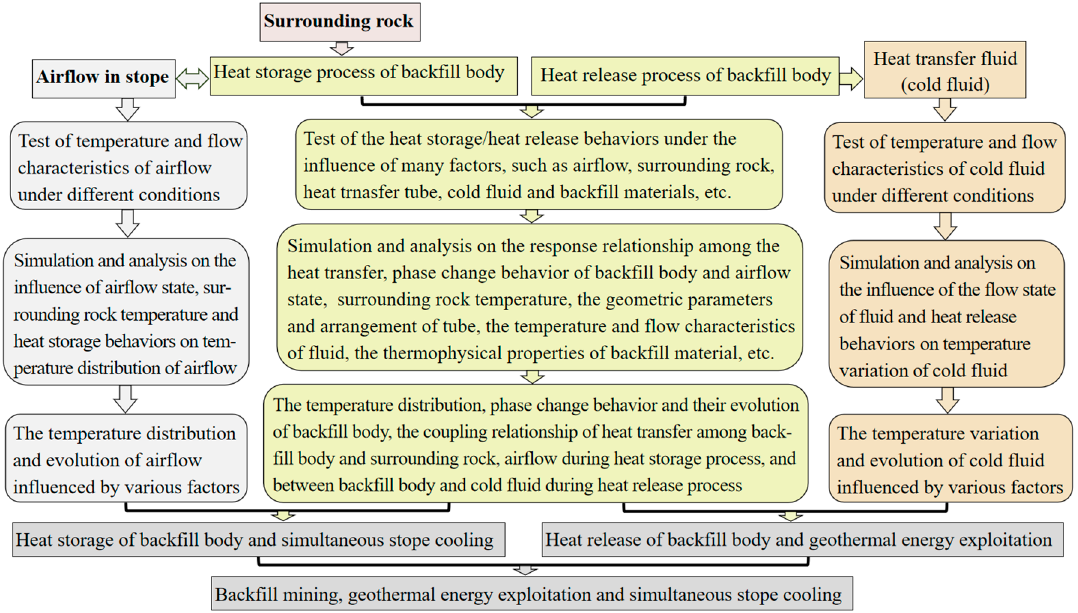
Figure 5. The mutual cooperation on backfill mining, geothermal energy exploitation and simultaneous stope cooling.